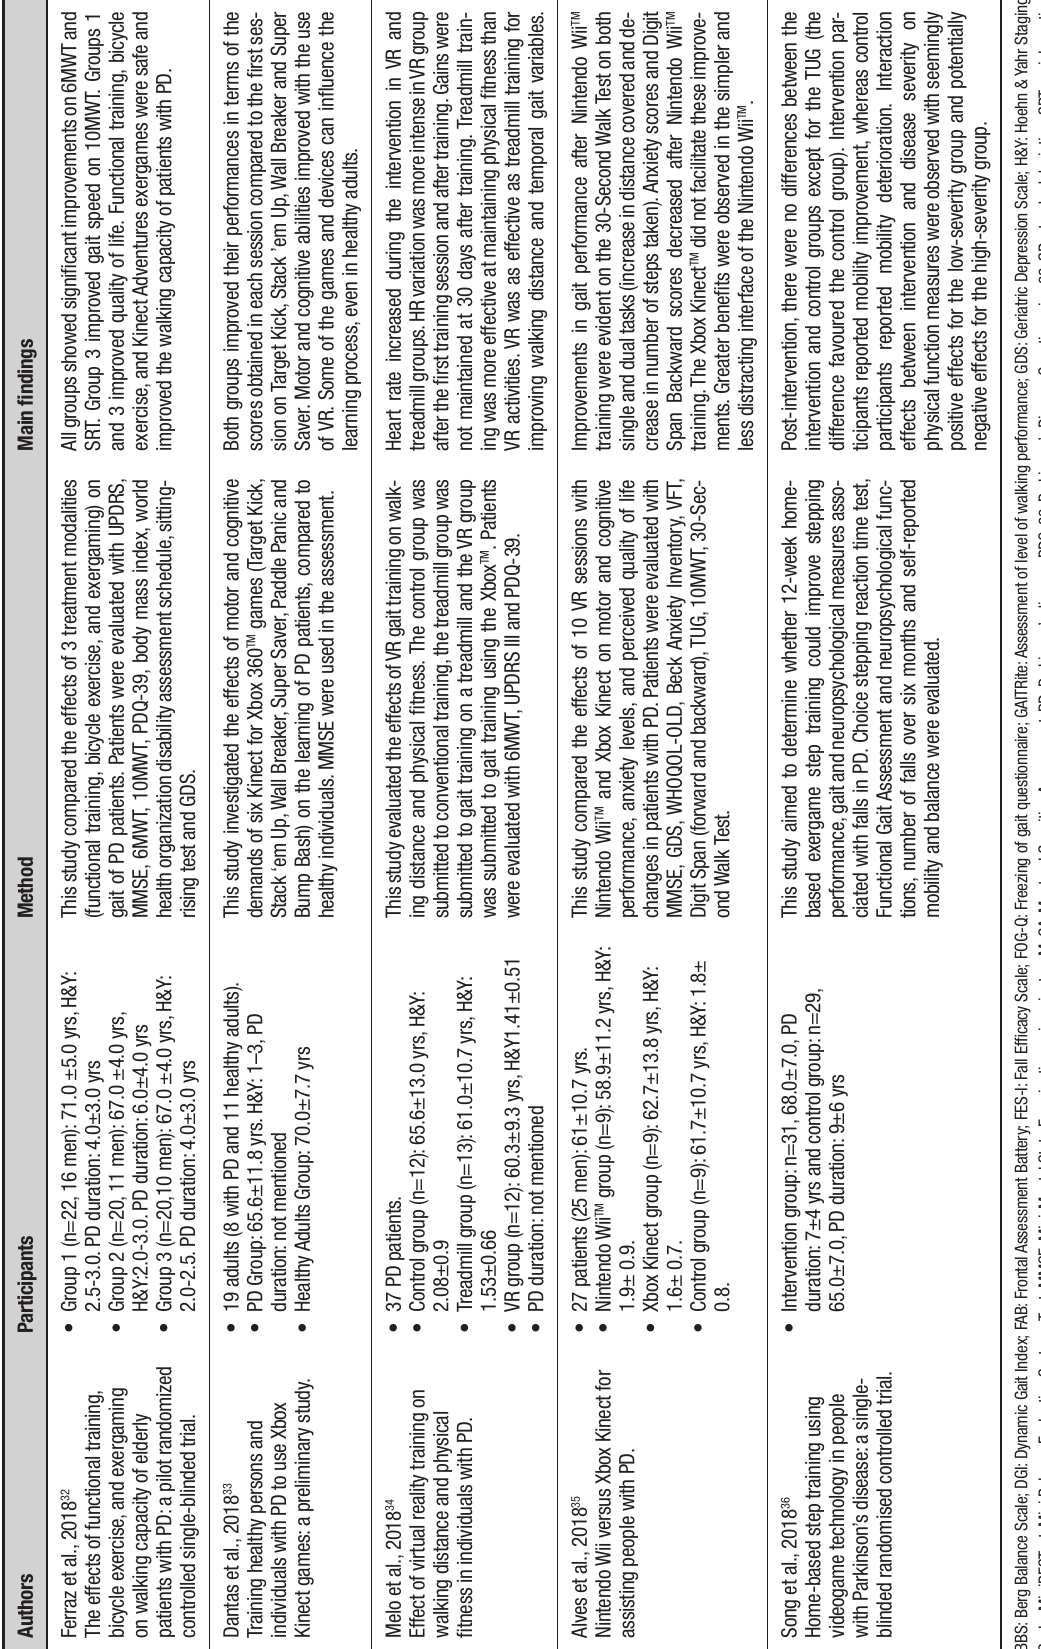
264 Visual reality and gait in Parkinson’s disease Freitag et